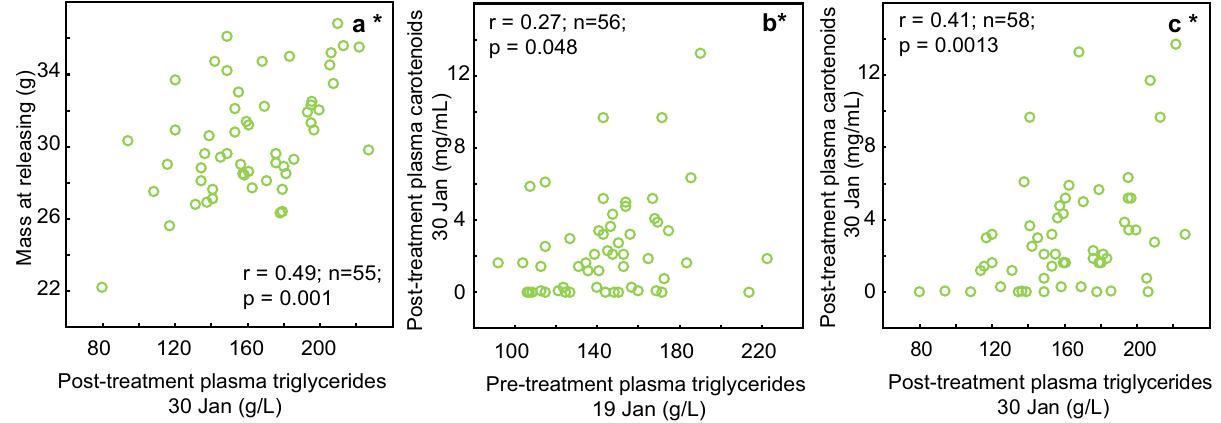
Figure 6. Correlations between physiological and biochemical traits. Asterisks after the panel letter indicate significant